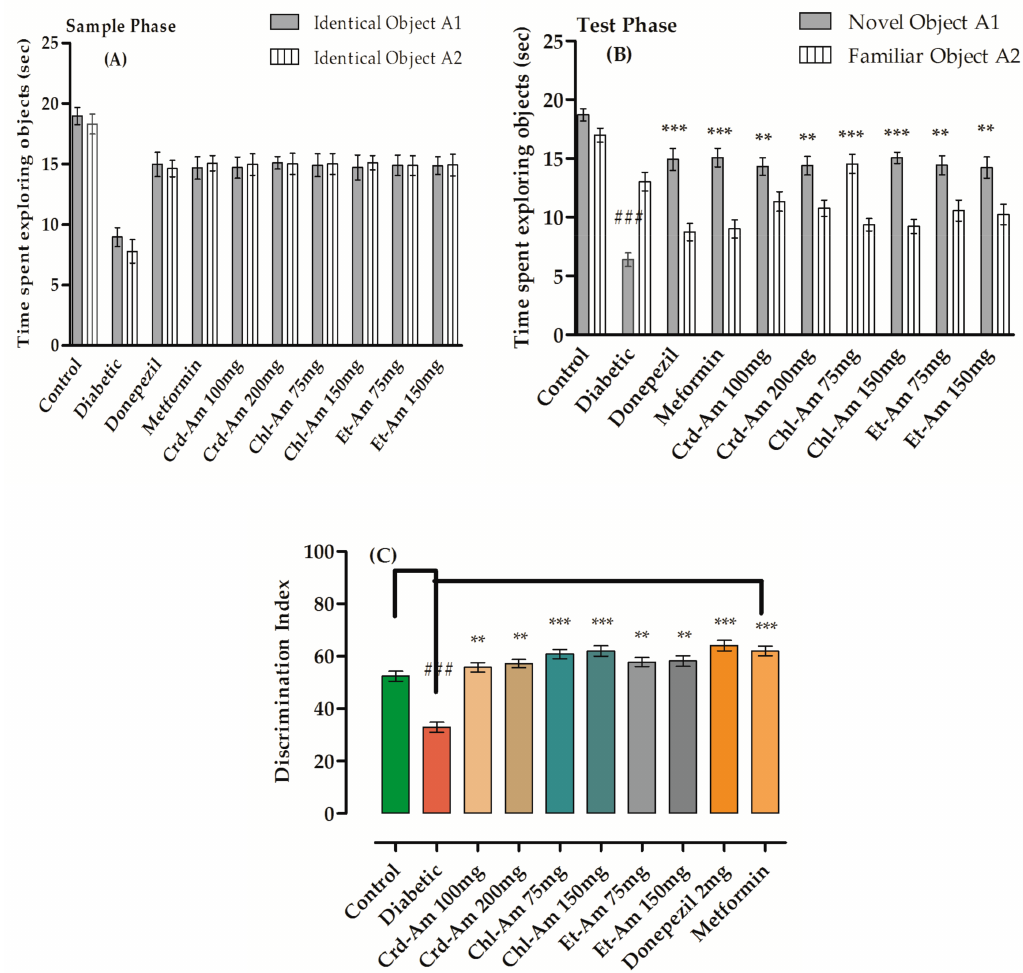
Figure 1. Behavioral results from novel object recognition test (NORT) in short term memory on crude extract and its fractions of A. macrocephala . Time spent in sample phase is ( A ) and time in test phase is ( B ), while index of % discrimination, ( C ) is noted for crude extract (200 and 100 mg/kg) and fraction (150 and 75 mg/kg)-treated groups versus STZ-treated diabetic group for the evaluation and recognition of memory in mice models. Mean ± SEM ( n = 6). One-way ANOVA is followed by Dunnett’s post hoc multiple comparison test. ### p < 0.001 comparison of STZ-treated diabetic (amnesic) group vs. normal control, ** p < 0.01 and *** p < 0.001 as comparison of STZ-treated diabetic (amnesic) group vs. Donepezil-, Metformin-, crude extract- and fraction-treated groups, using one-way ANOVA followed by Dunnett’s comparison. Crude extract (Crd-Am), hexane (nhex-Am), chloroform (Chl-Am), ethyl acetate (Et-Am), butanol (But-Am) and aqueous (Aq-Am)